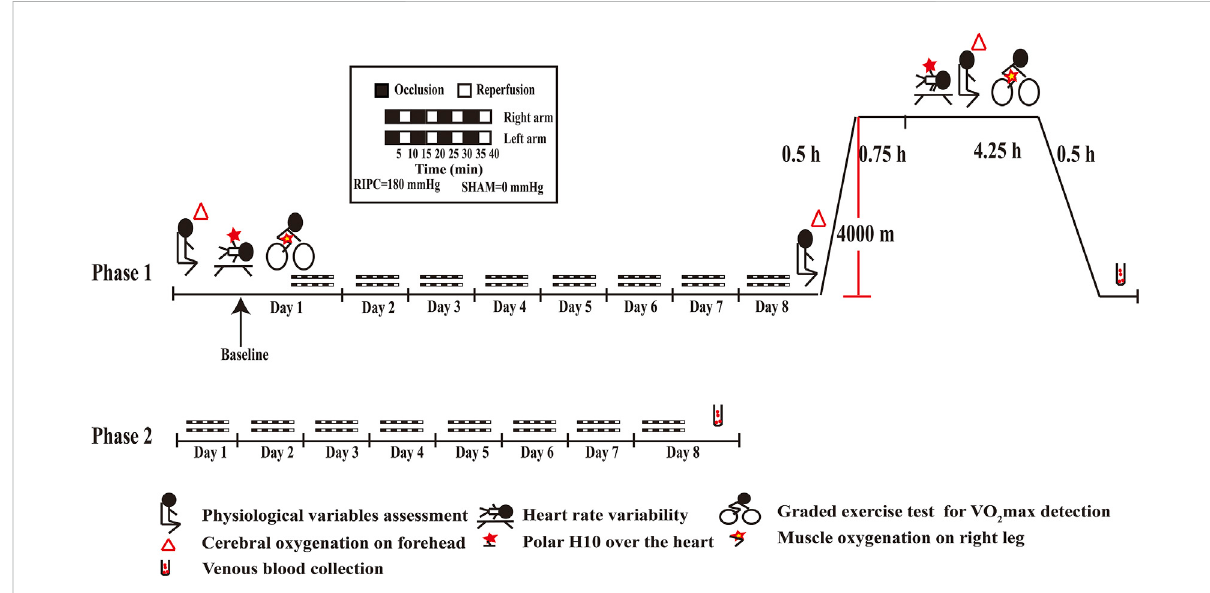
FIGURE 2 Schematic diagrams of RIPC intervention and examinations. RIPC: remote ischemic preconditioning.